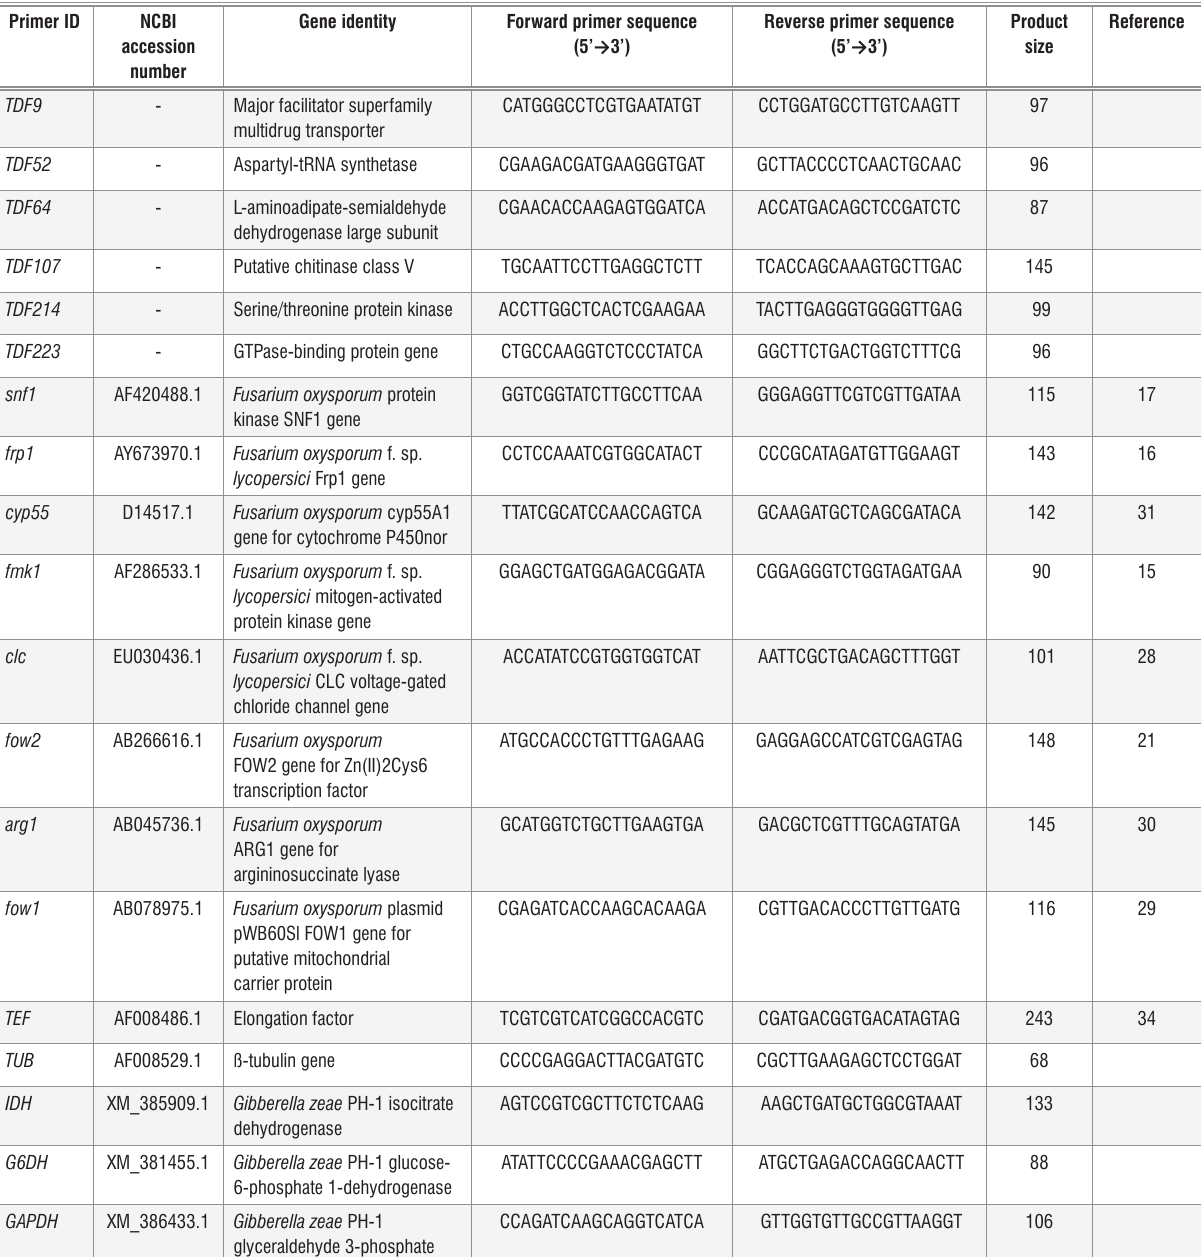
Table 3: Primer sequences of genes from Fusarium spp . used in reverse transcription real-time quantitative PCR analysis Primer